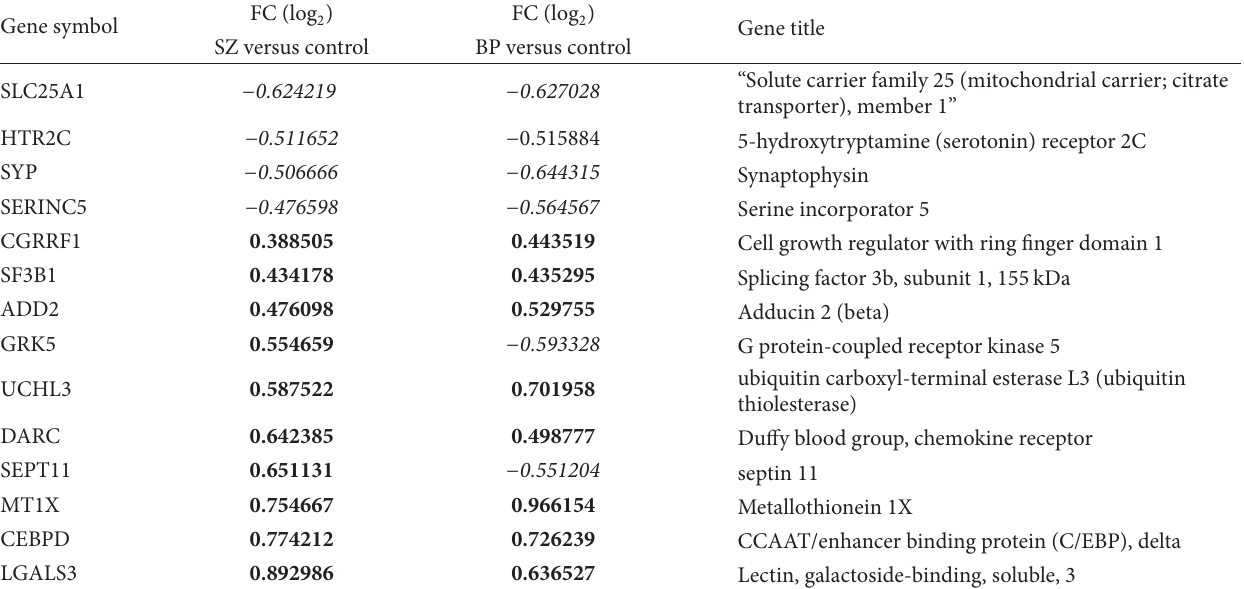
T 5: �e fourteen common DE genes in schi�ophrenic and BD samples compared to control samples derived from the �rst